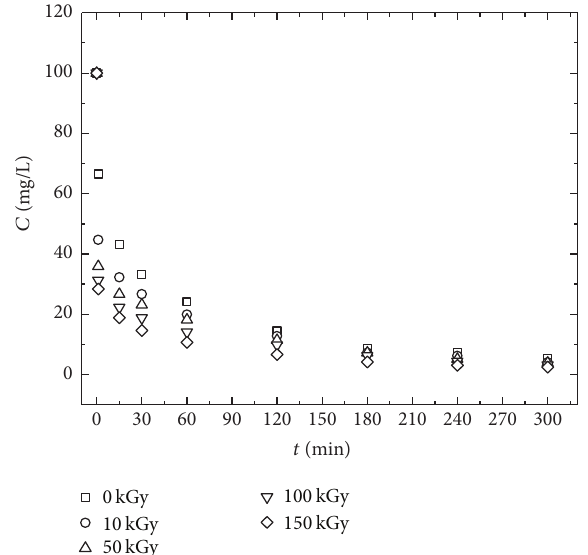
Figure 2: Kinetics of the lead adsorption process for nonirradiated and irradiated minerals ( 𝐶 0 = 100 mg/L, 𝑇 = 20 ∘ C, 𝑤 = 1 g, and 𝑉 = 0.1